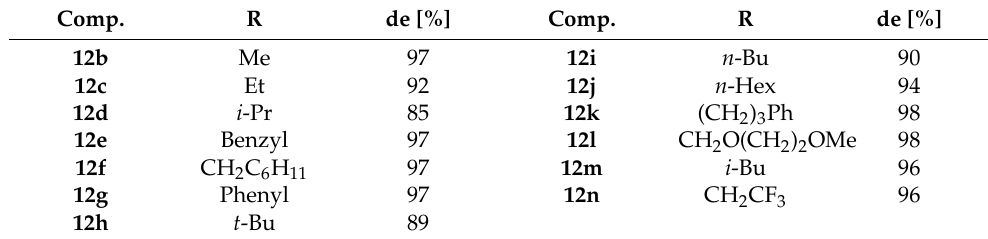
Table 1. Diastereomeric excess (de) for Mosher derivatives ( R , R )-12b-n . Comp.